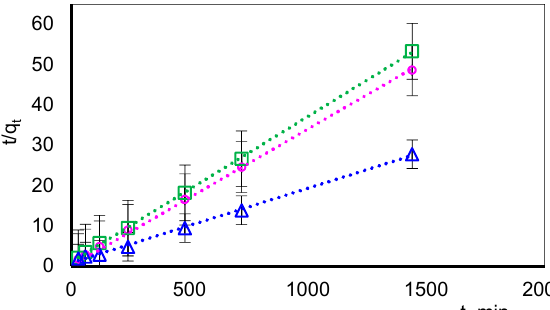
Figure 6. The PSO function matching to the experimental data obtained in the adsorption of Zn(II) (o), Cu(II) ( □ ) and Pb(II) ( ∆ ) ions on composite D. The obtained data are presented in Table 7.